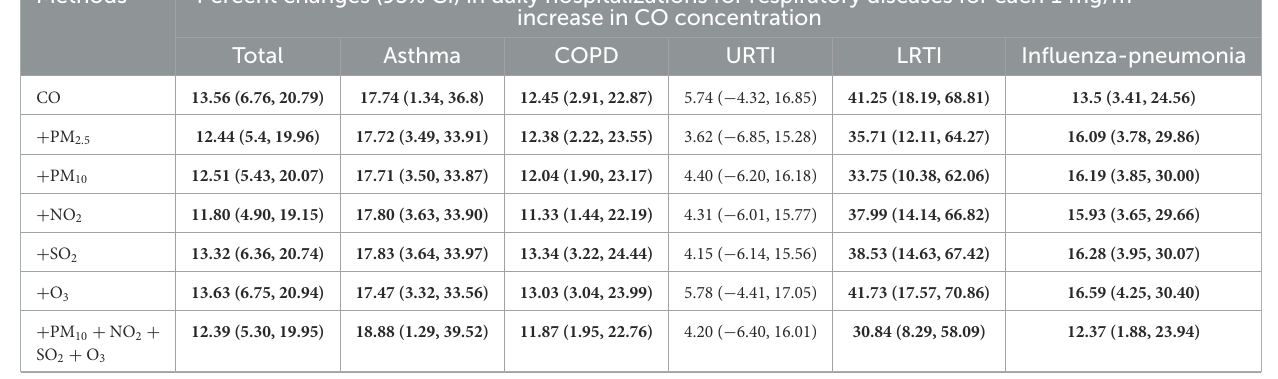
TABLE 2 Percent changes (95% CI) in daily hospitalizations for respiratory diseases for each 1 mg/m 3 increase in carbon monoxide with adjustment for co-pollutants.